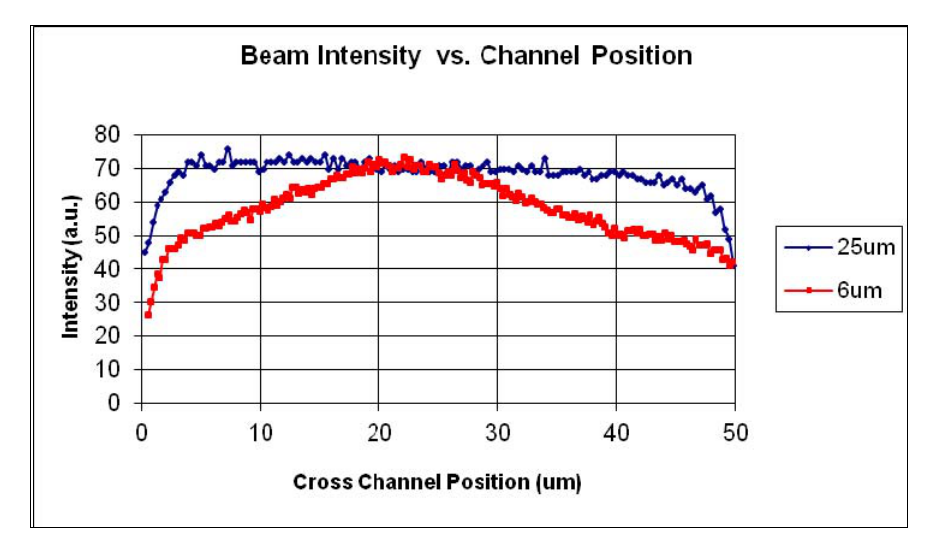
Figure 6. Plot showing the intensity of the beam as a function of the cross channel dimension. The x dimension is the vertical direction of the pictures in Figure